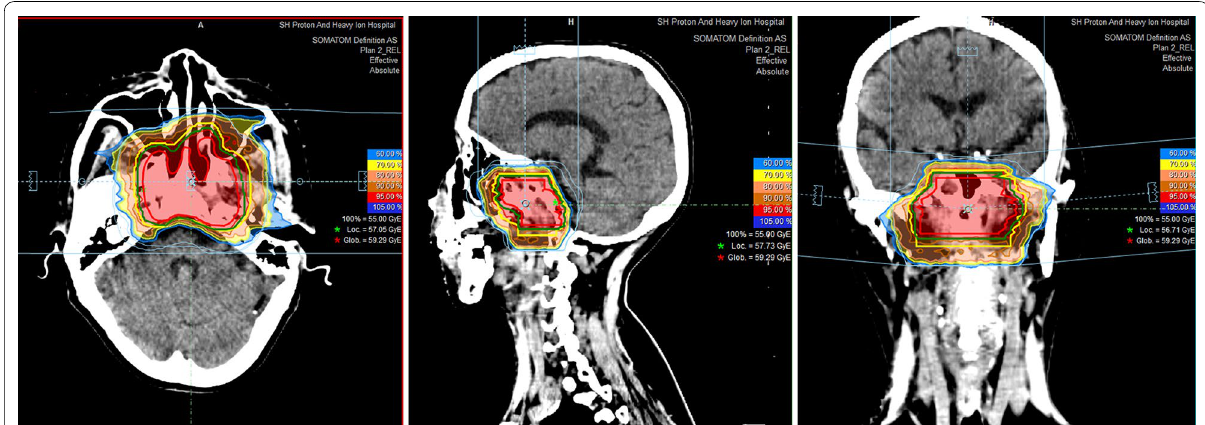
Fig. 1 Typical treatment plan and dose distribution for intensity-modulated carbon-ion radiotherapy delivered using the raster-scanning technique in a patient with stage rT3N0M0 nasopharyngeal carcinoma with recurrence at the base of the skull. Transverse, sagittal, and coronal views are pro- vided. The red , orange , yellow , and blue shaded areas represent 95%, 85%, 70%, and 30% isodose lines; the red , green , and yellow lines represent gross tumor volume (GTV), GTV 3 mm, and clinical target volume (CTV), +